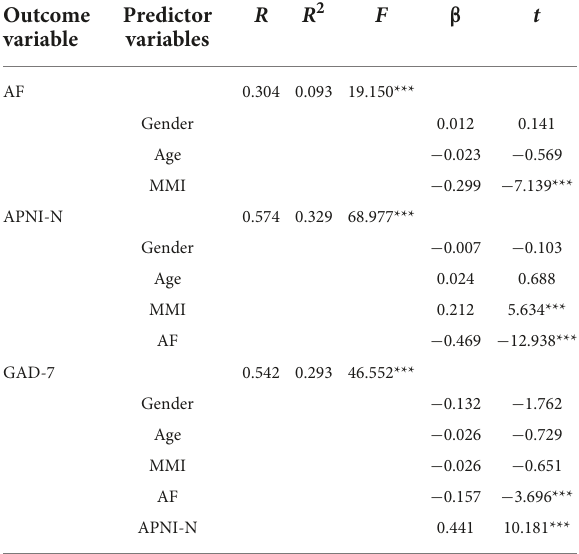
TABLE 2 Regression analysis of variable relationships in models.